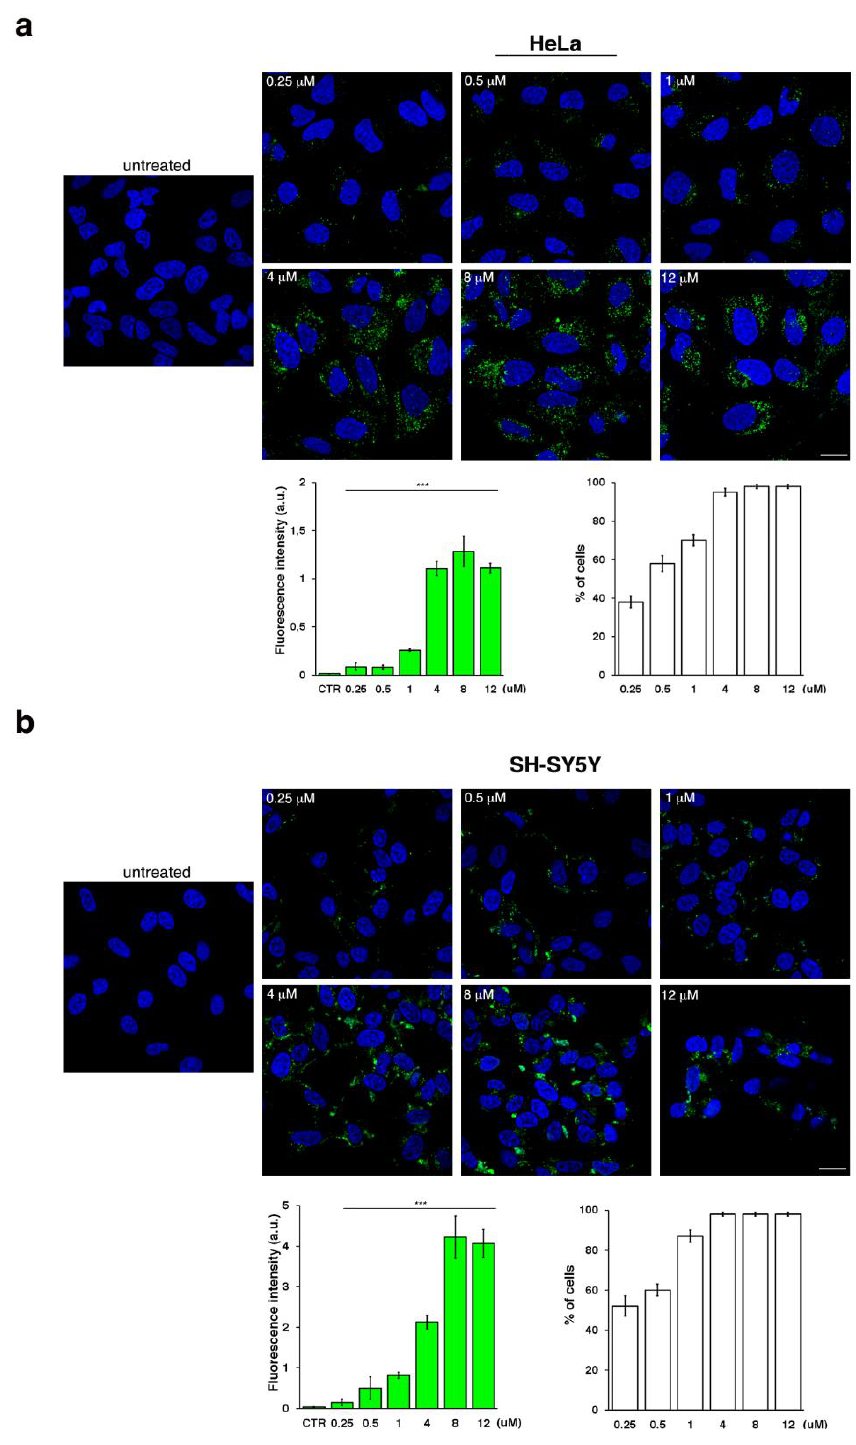
Figure 4. FITC-MS3 uptake in different cell lines. HeLa ( a ) or SH-SY5Y ( b ) cells were incubated with FITC-conjugated MS3 (green) for 24 h at different concentrations, as indicated. Then, cells were fixed, and nuclei were stained with DAPI (blue). Images were acquired with a confocal microscope. Scale bars, 6 µM. Mean fluorescence intensity normalized per cell area (arbitrary unit, a.u.) of three independent experiments is shown (left graph), n > 50 cells; error bars, mean ± SD. *** p < 0.0001, Student t -test. The percentage of fluorescent cells, measured as number per field, is shown (right graph); error bars, mean ± SD. Note that the percentage of fluorescent cells increased in dose-dependent manner ( p < 0.001, Student t -test), reaching a plateau at the concentration of 4 µM (no statistical significance among 4, 8, 12 µM, Student t -test).